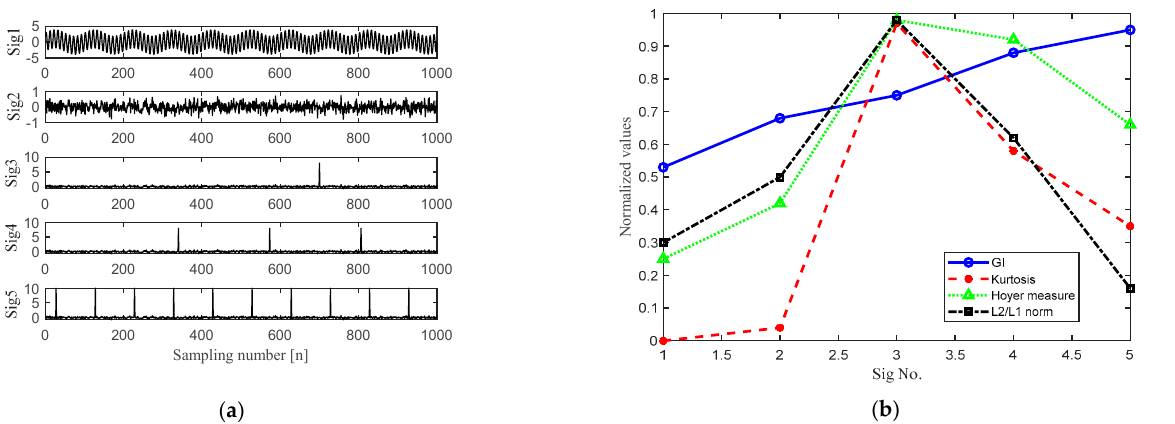
Figure 4. Five signals with their four indexes. ( a ) Five signals. ( b ) Four indexes corresponding to the five signals as shown in ( a ).